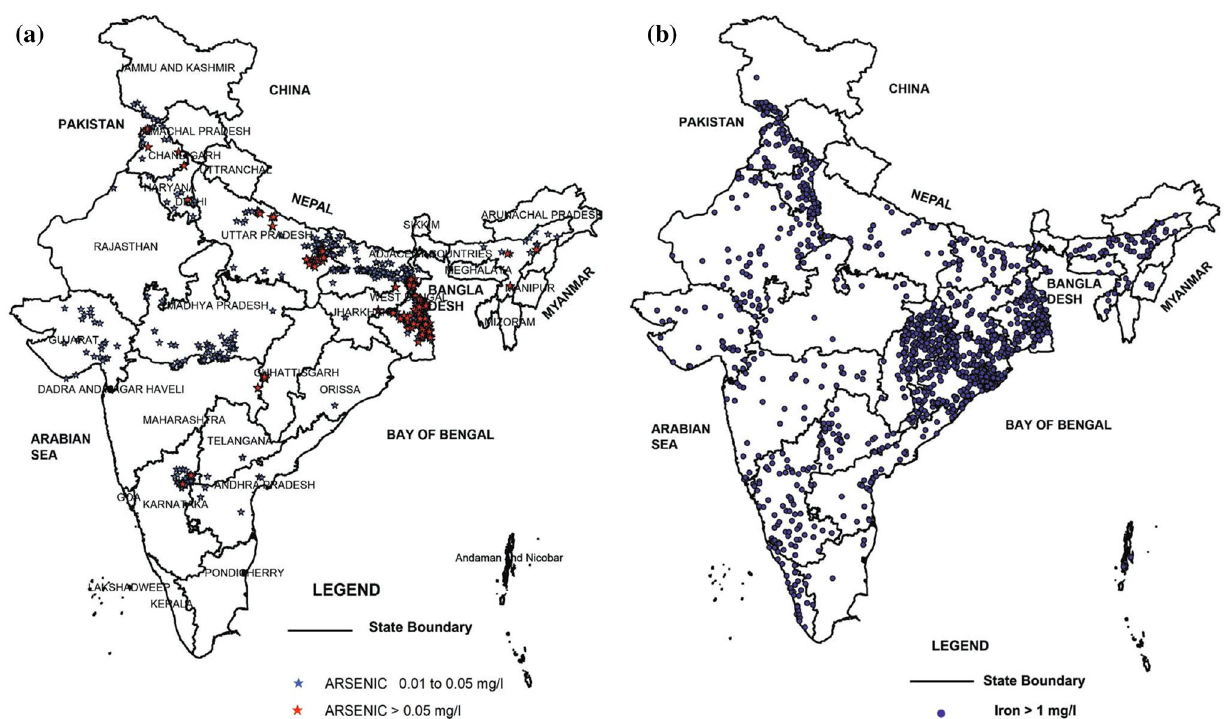
Fig. 6 The water quality condition of India in terms of heavy metal parameters, a Arsenic, b Iron ( Source CGWB